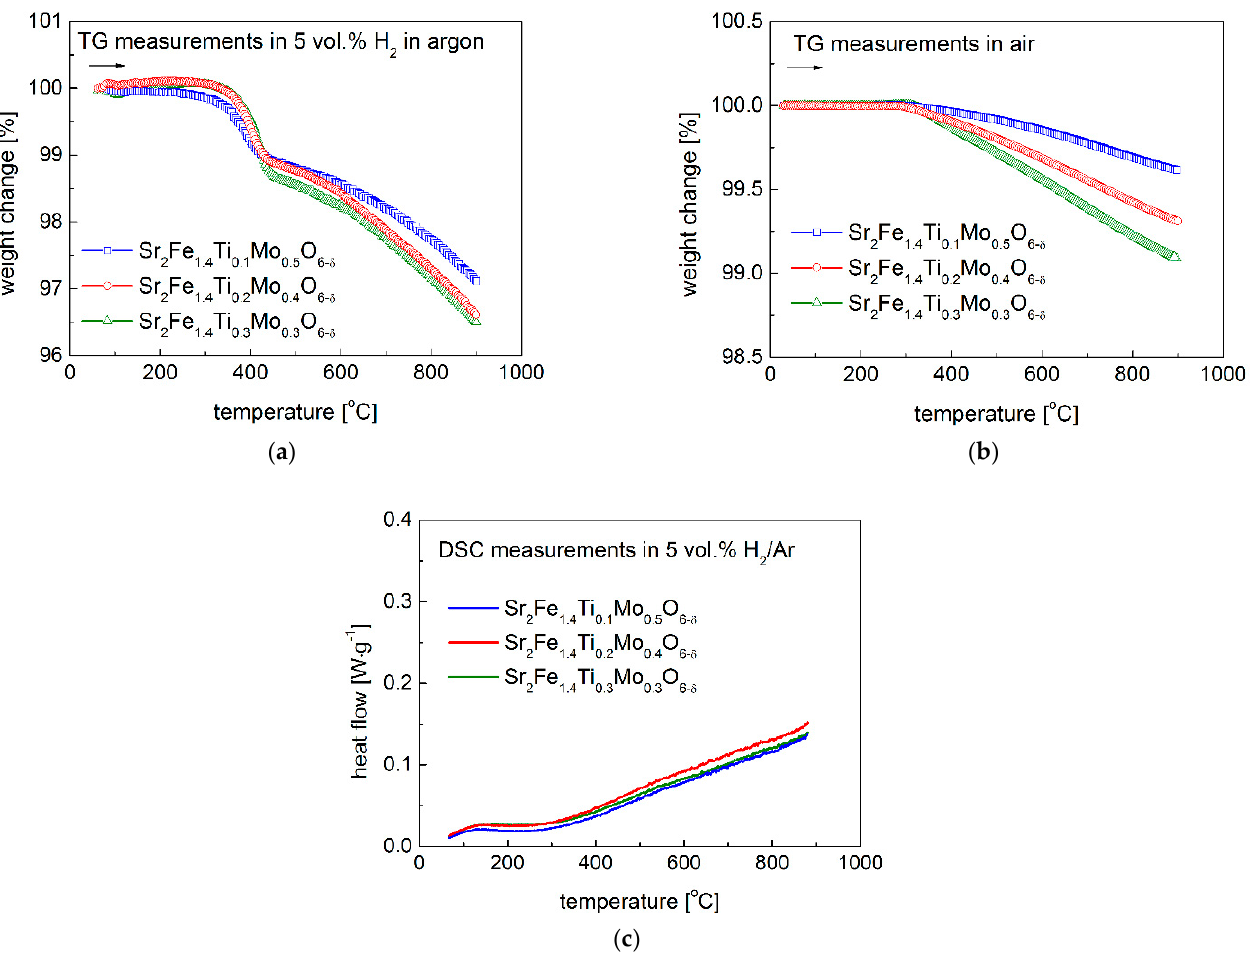
Figure 7. Oxygen content change of Sr 2 Fe 1 . 4 Ti x Mo 0 . 6 − x O 6 −δ materials ( a ) in air and ( b ) in 5 vol.% H 2 in argon; ( c ) results of DSC measurements for Sr 2 Fe 1 . 4 Ti x Mo 0 . 6 − x O 6 −δ (x = 0.1, 0.2 and 0.3) oxides in 5 vol.% H 2 /Ar.